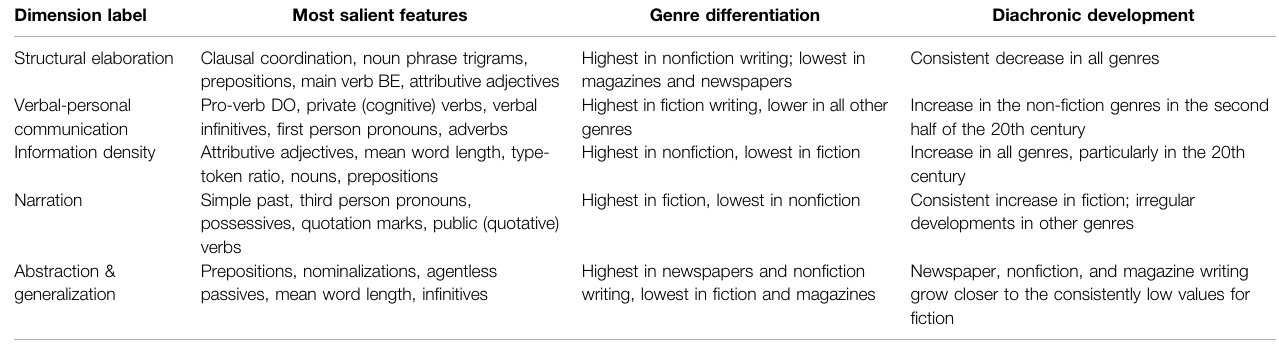
TABLE 1 | The fi ve dimensions of variation in